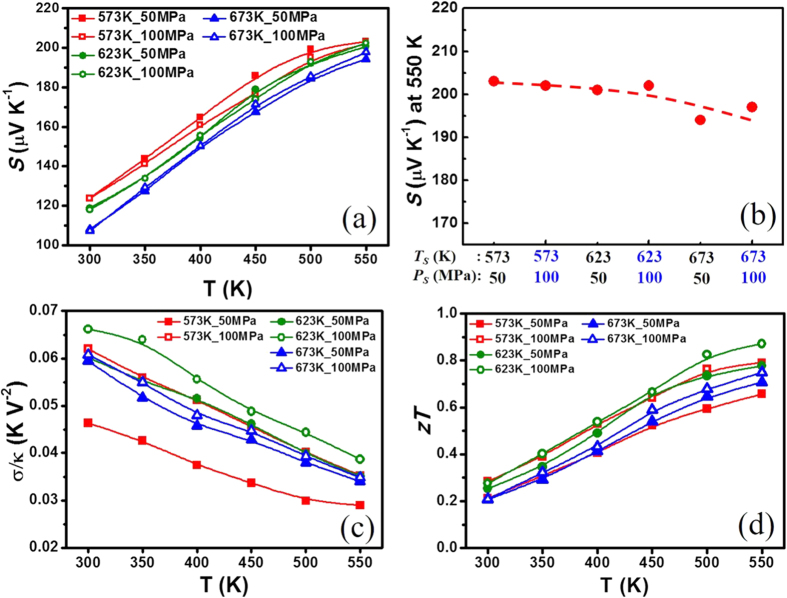
Temperature dependence of (a) Seebeck coefficient, (b) Seebeck coefficient at 550 K as a function of sintering temperature (Ts) and pressure (Ps), (c) σ/κ ratio, and (d) zT values for Sb1.85In0.15Te3 prepared by various SPS sintering conditions.